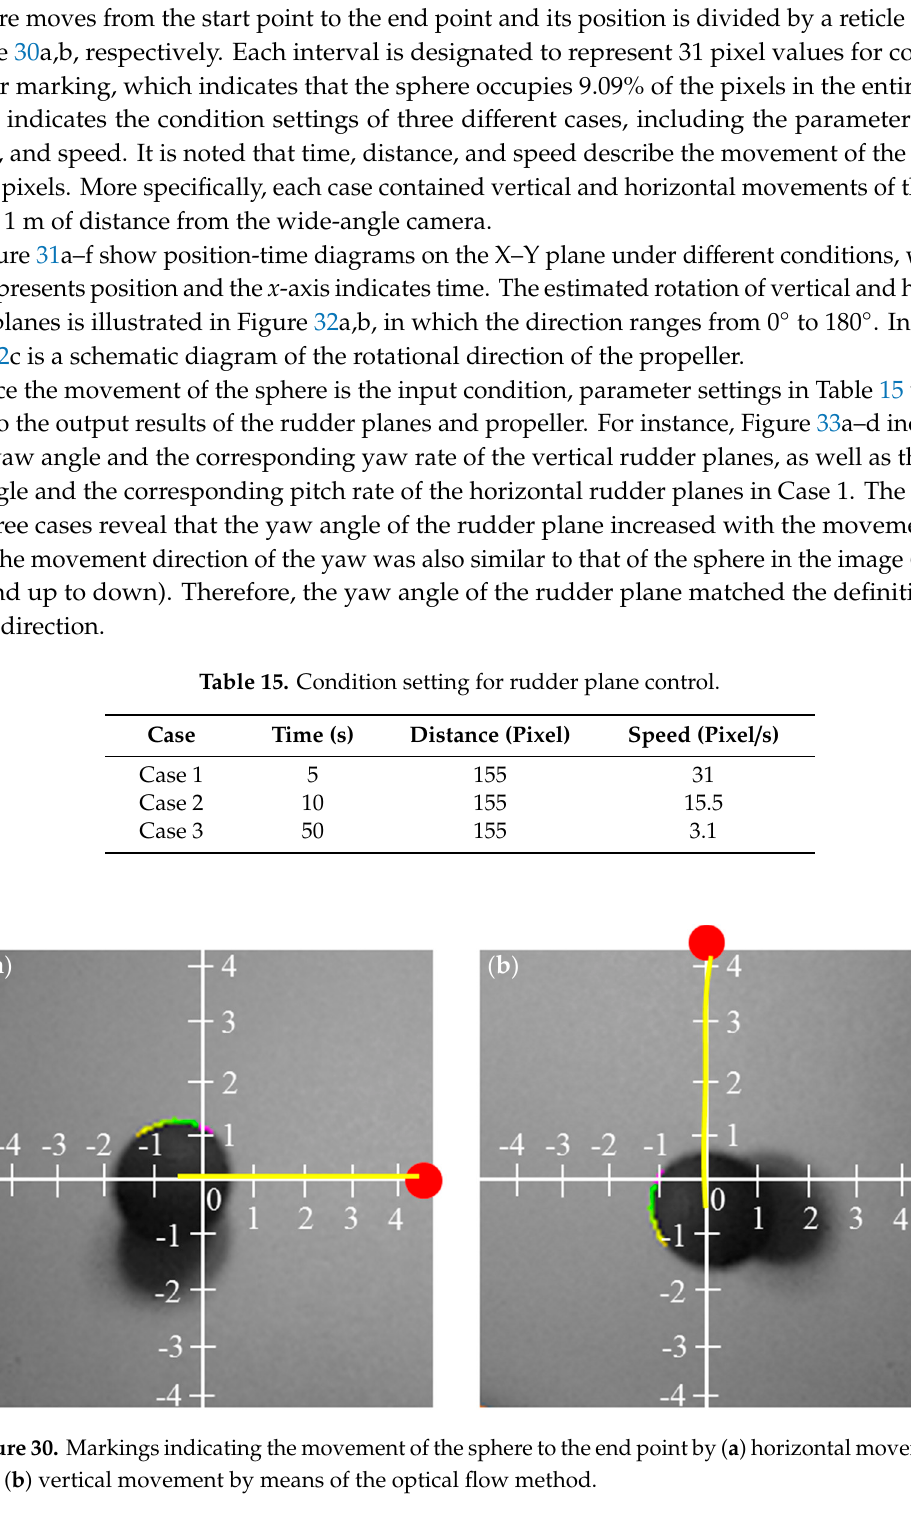
Figure 31. Position–time diagrams of X–Y plane: ( a ) x -axis and ( b ) y -axis in Case 1; ( c ) x -axis and ( d ) y -axis in Case 2; and ( e ) x -axis and ( f ) y -axis in Case 3.